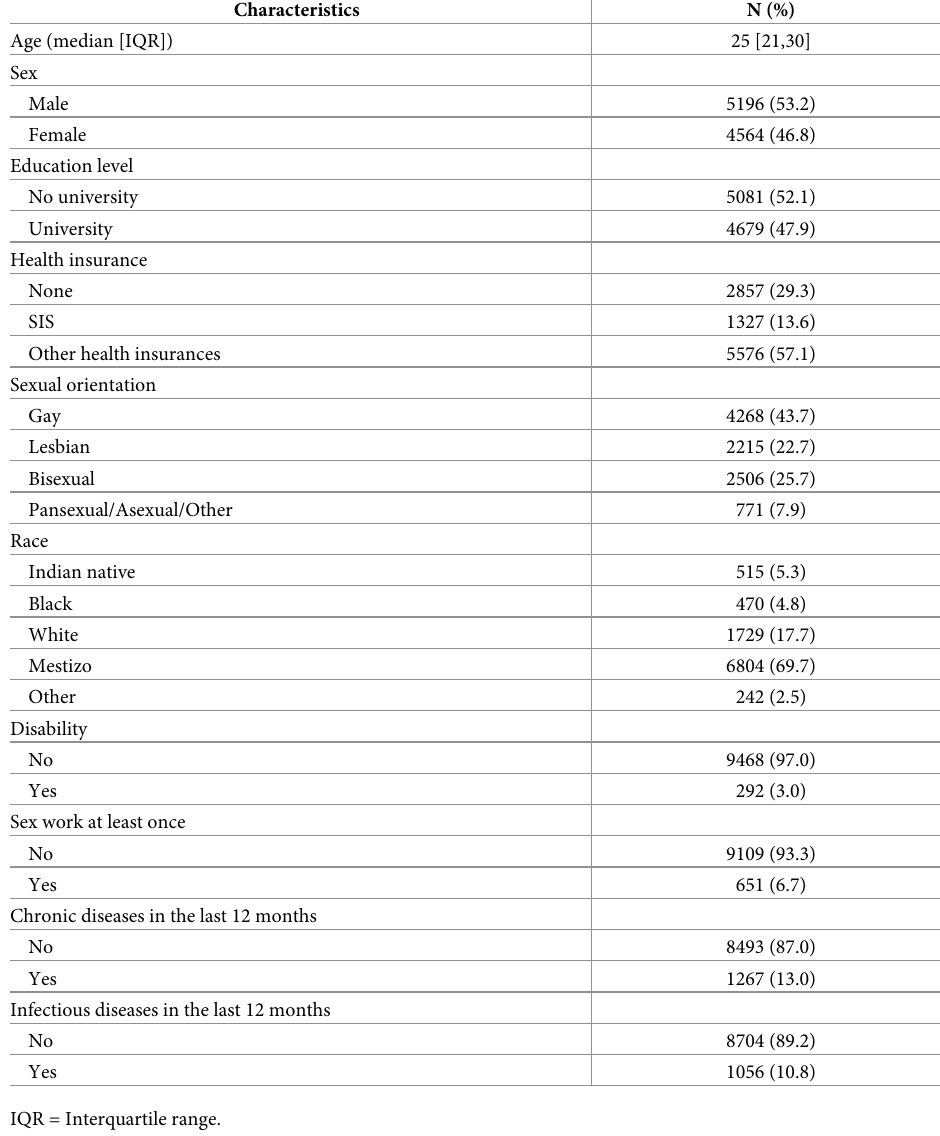
Table 1. General characteristics, mental health problems and discrimination experiences among Peruvian sexual minorities aged 18 to 60 years old (n = 9760).